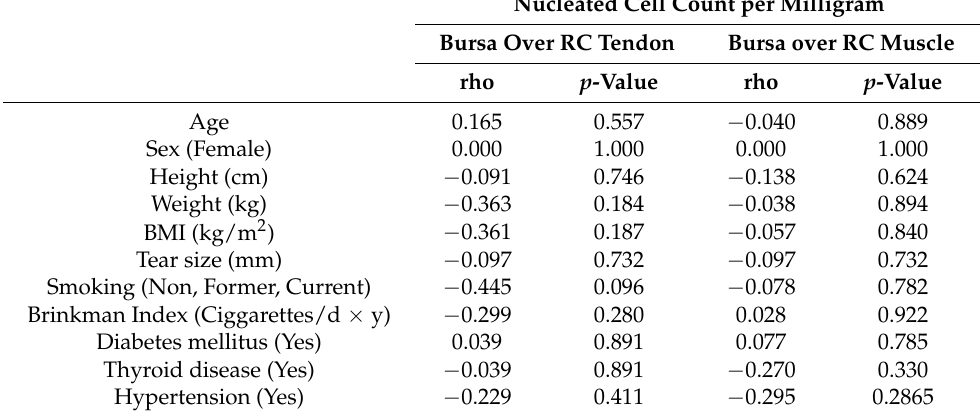
Table 2. Spearman’s rank correlation coefficient analysis of nucleated cell count (NCC) from the SB over RC tendon and muscle. There was no statistical correlation with all patient demographics and tear characteristics. Nucleated Cell Count per Milligram Bursa Over RC Tendon Bursa over RC Muscle rho p -Value rho p -Value Age 0.165 0.557